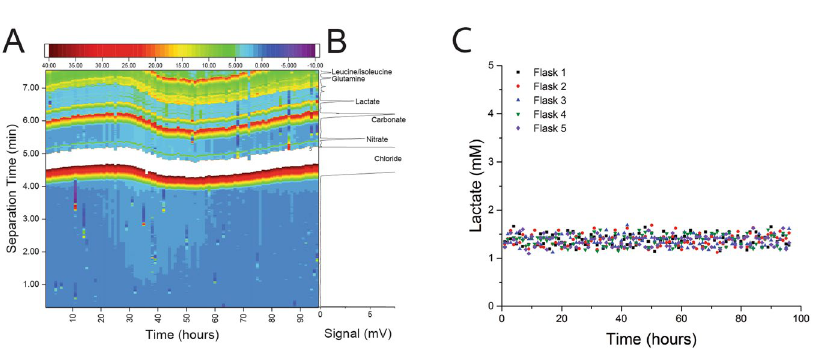
Table 1. Sequence of events and volumes of BGE, sample and sample carrier solution used by the SI-CE system.